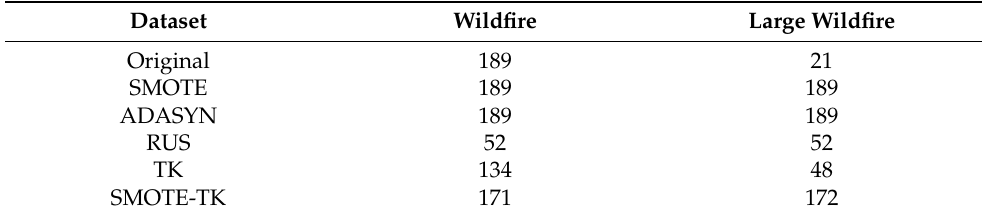
Figure 4. Selection of variables based on ( a ) Gini Index and ( b ) Out of Bag accuracy results. Once the variables were selected, different synthetic data generation methods were applied to balance the sample. Table 3 shows the sample size of each dataset generated. Table 3. Sample size of wildfire and large wildfire per original and synthetic datasets.